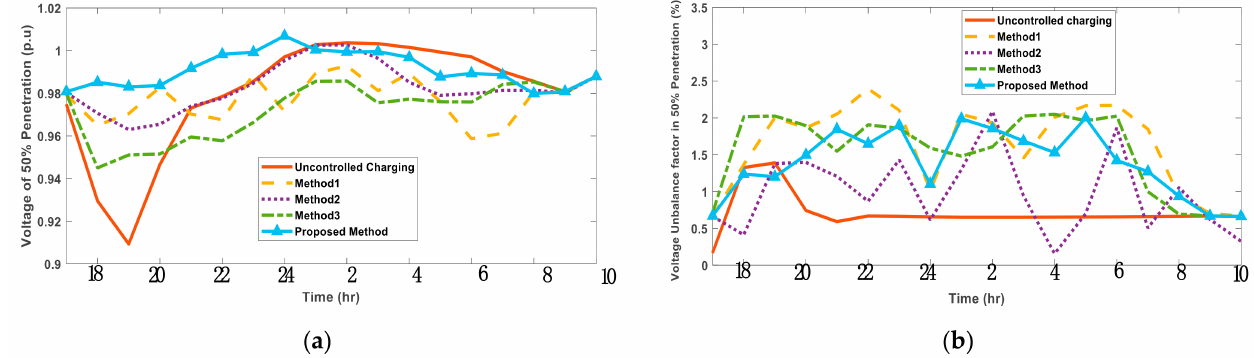
Figure 10. Bus 846 ( a ) voltage and ( b ) VUF under 50% EV penetration. At 75% penetration, the bus voltage profile is improved for most methods, but lies closest to the desired voltage with the proposed method, as shown by Figure 11a. The plot of VUF as given by Figure 11b shows that the VUF exceeds the 2% limit with other methods but it lies within the limits for the proposed method.